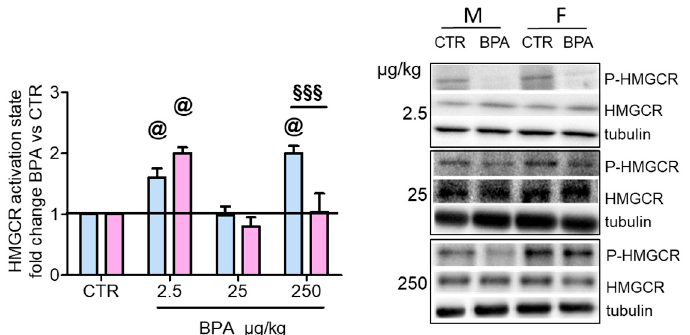
Figure 2. Activation state of HMGCR in the brain of rat fetuses in utero exposed to di ff erent doses of BPA. On the left, HMGCR activation state in male (M, blue) and female (F, pink) fetuses of dams exposed to three di ff erent doses of BPA (2.5- 25- 250 µ g / kg / day) The substance was administered through drinking water starting 30 days before the beginning of pregnancy until their sacrifice at GD 20. HMGCR activation state was estimated by the ratio of total and phosphorylated form of the enzyme and normalized to the values of the vehicle-treated animals. Tubulin served as housekeeping protein to correct for protein loading. n = 6 for each experimental group. Images on the right show representative Western blots. Statistical analysis was carried out by two-way ANOVA followed by Bonferroni post-hoc test among the sample treated with the same dose. @ = p < 0.001 vs. sex-matched CTR; §§§ = p < 0.001 between male and female.